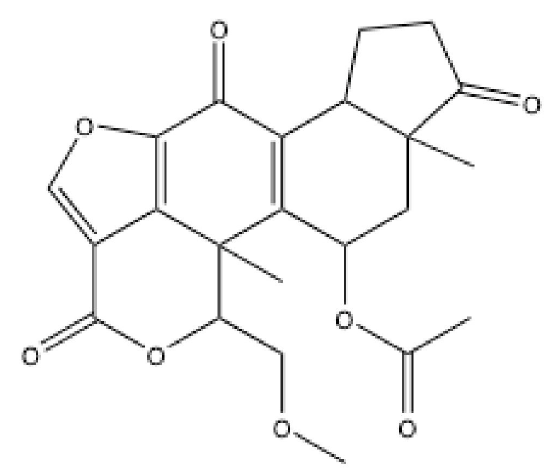
Figure 4. Structure of